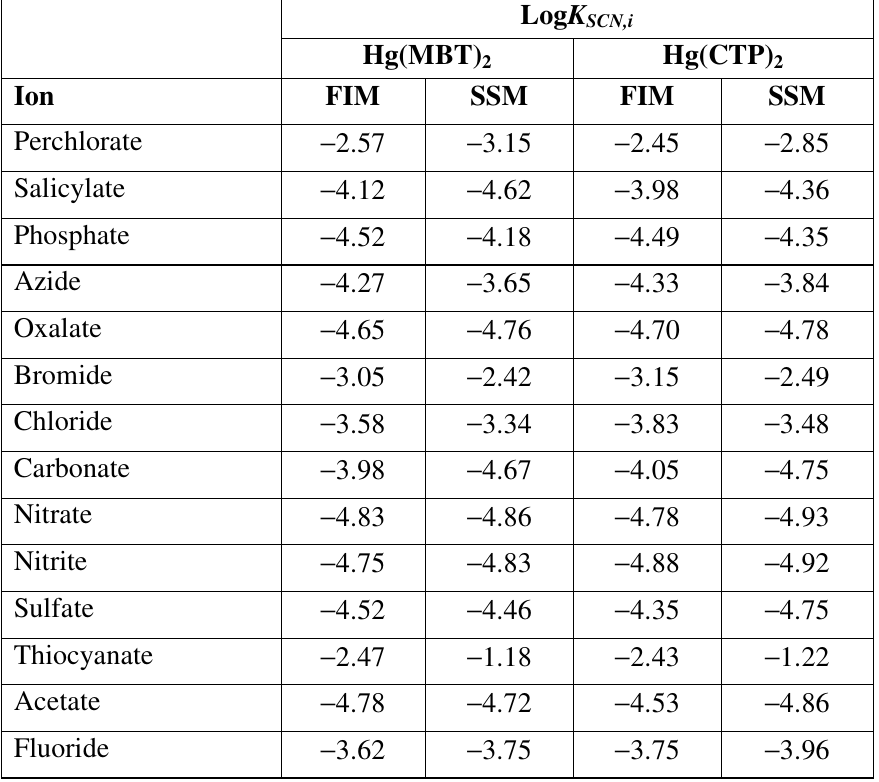
Table 3. Selectivity Coefficients of the Coated-Graphite Electrodes Based and Hg(MBT) on Hg(CTP) 2 2